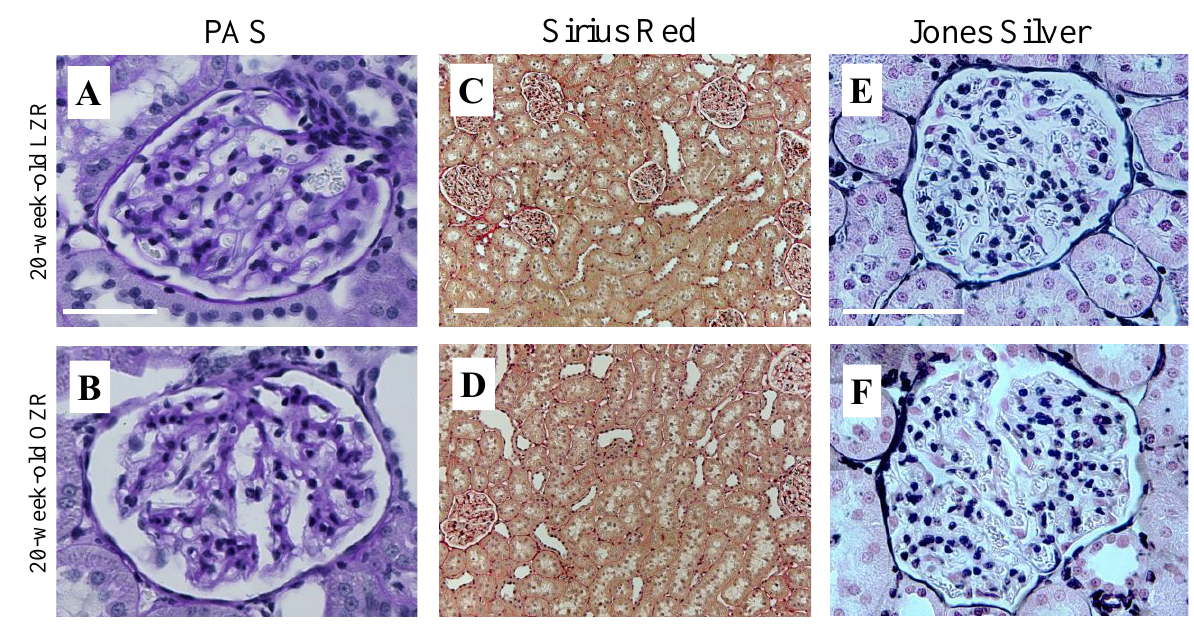
Figure 3. Histology images of kidney tissue from a 20-week-old lean Zucker rat (LZR) and obese Zucker rat (OZR) stained with PAS, Sirius Red, and Jones Silver. Images ( A , B ) show glomeruli with no significant mesangial hypertrophy, as the purple-colored carbohydrate would have expanded within the glomerulus. Images ( C , D ) primarily show the tubular network without tubulointerstitial fibrosis based on the level of red-stained collagen between the tubules. Images ( E , F ) show glomeruli without pathological thickening of the GBM. Scale bar: 50 µm (A + B + E + F), 100 µm (C + D).